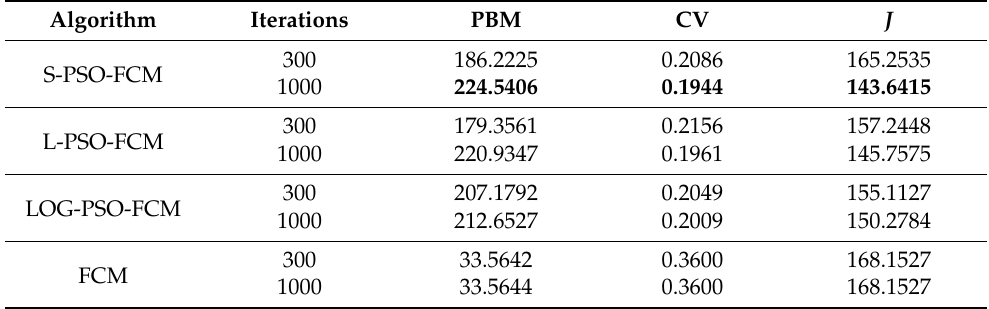
Table 5. Clustering indices of different algorithm results (best results are highlighted in bold).